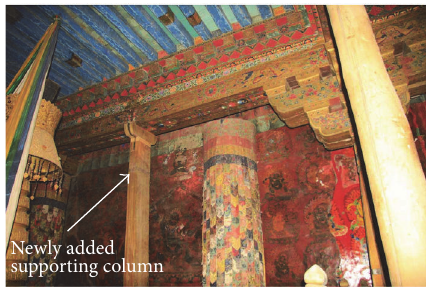
Figure 21: Rehabilitation method for beam with large